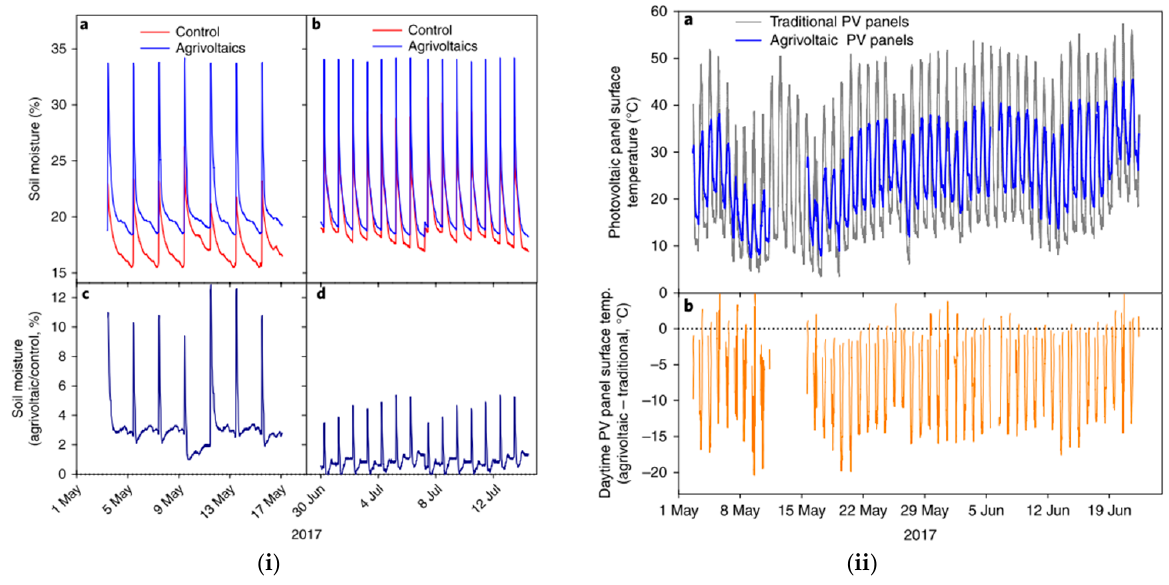
Figure 3. ( i ) Impacts of agrivoltaic over control installations on soil moisture: ( a , b )—the comparison between control plots and agrivoltaics on soil moisture; ( c , d )—di ff erences between soil moisture in the agrivoltaic and in the control se tt ings where positive values mean additional moisture in the agrivoltaic se tt ing. ( ii ) impacts of agrivoltaic over traditional ground-mounted installations on the surface temperature of PV panels: ( a )—the comparison between the surface temperature of tradi- tional PV panels and the surface temperature of agrivoltaic PV panels; ( b )—di ff erences in PV panel temperature between the agrivoltaic and traditional se tt ings where negative values mean the degree to which PV panels in the agrivoltaic were cooler. Reproduced with permission [34]. Copyright 2018, Springer Nature.